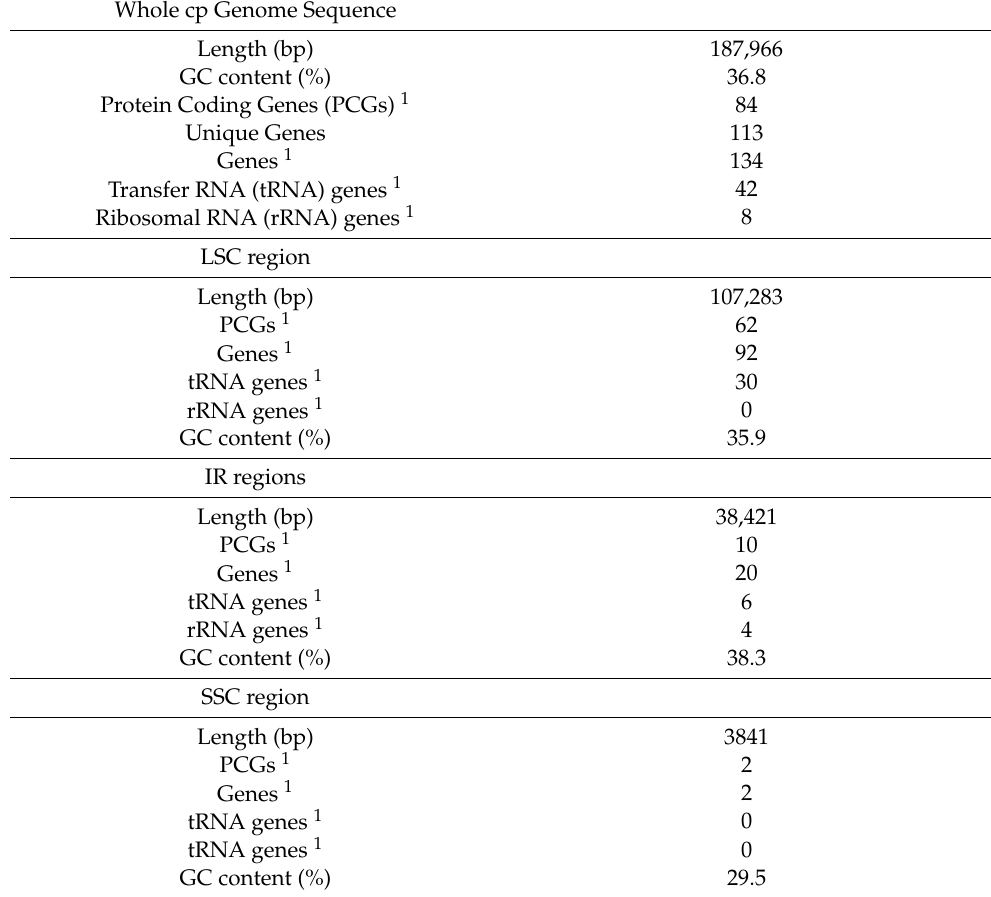
Table 1. Assembly and annotation statistics of the cp genome of V. floribundum